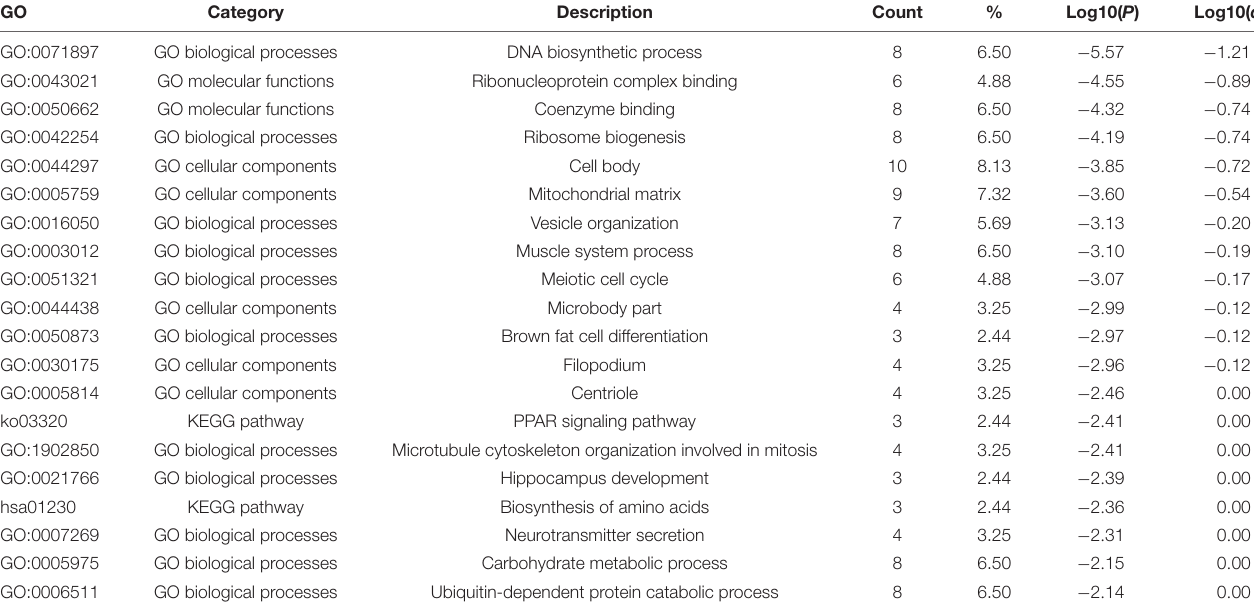
TABLE 3 | Function enrichment analysis list of SMYD family members and adjacent genes Go and KEGG in ESCA, LIHC, and STAD (Metascape). GO